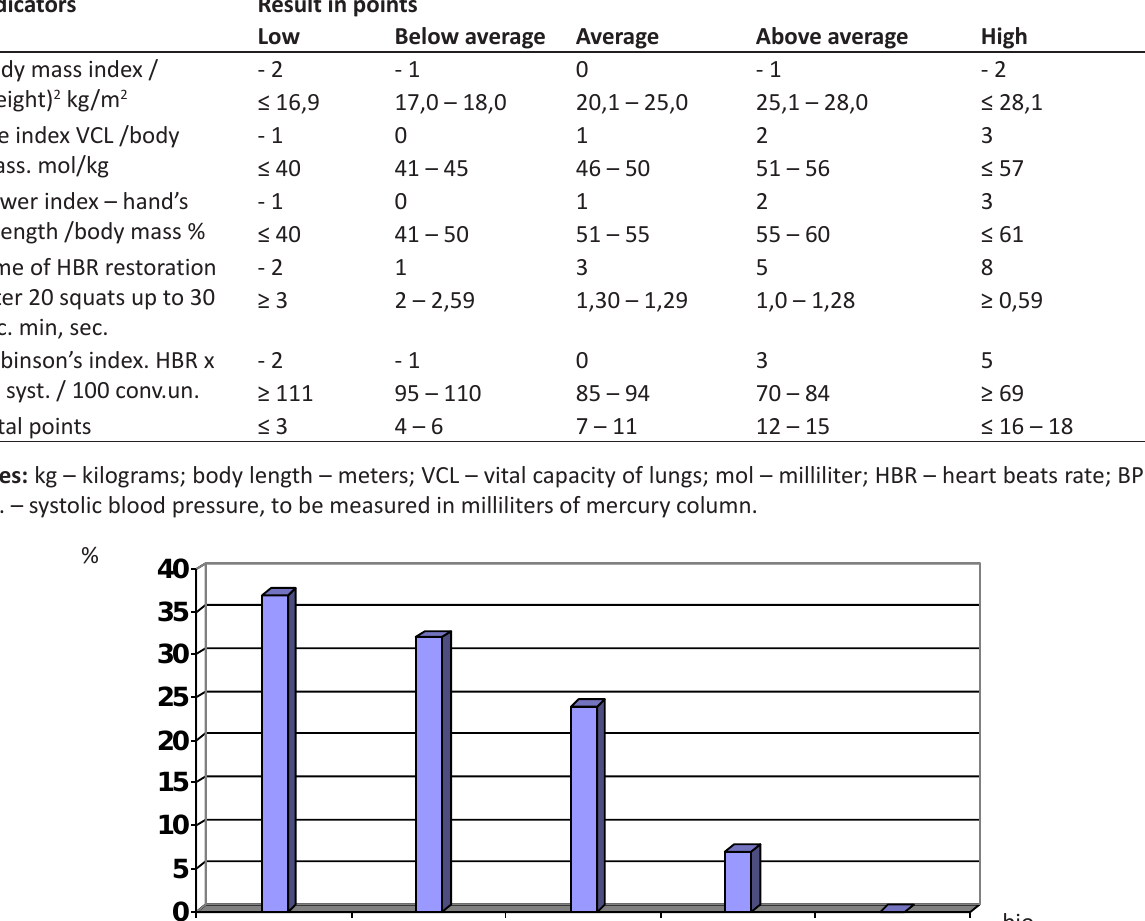
Table 1. Scale of assessment of physical health for women Indicators